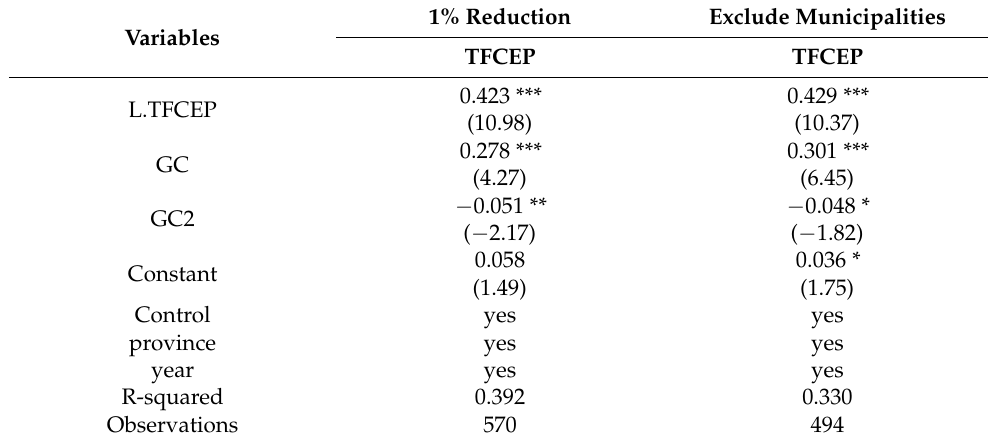
Table 8. Summary of various robust